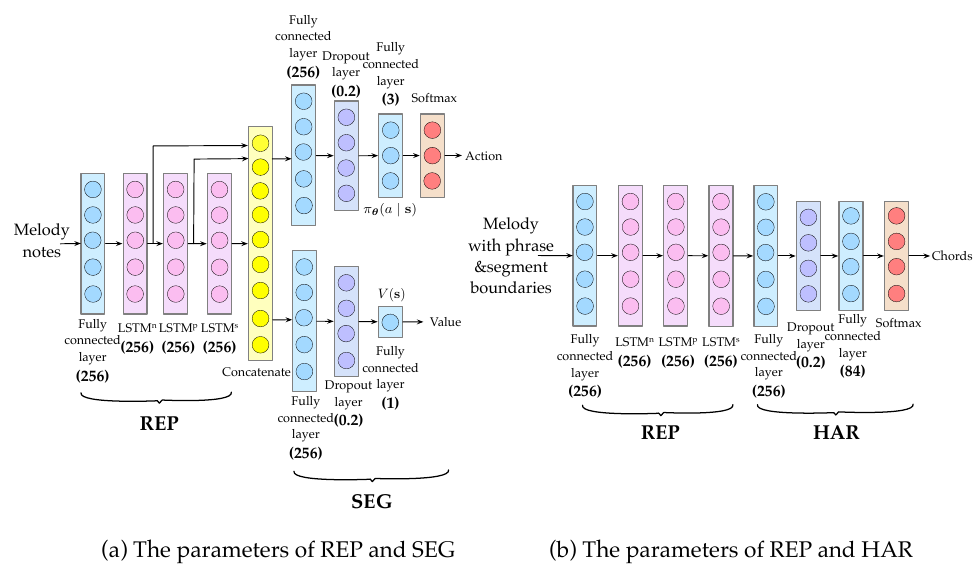
Figure 8. The experiment settings for REP, SEG and HAR and how they interact with each